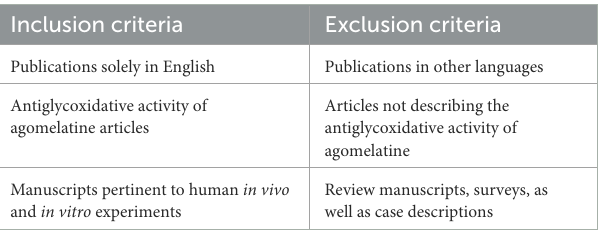
TABLE 1 Analyzed publications’ inclusion and exclusion